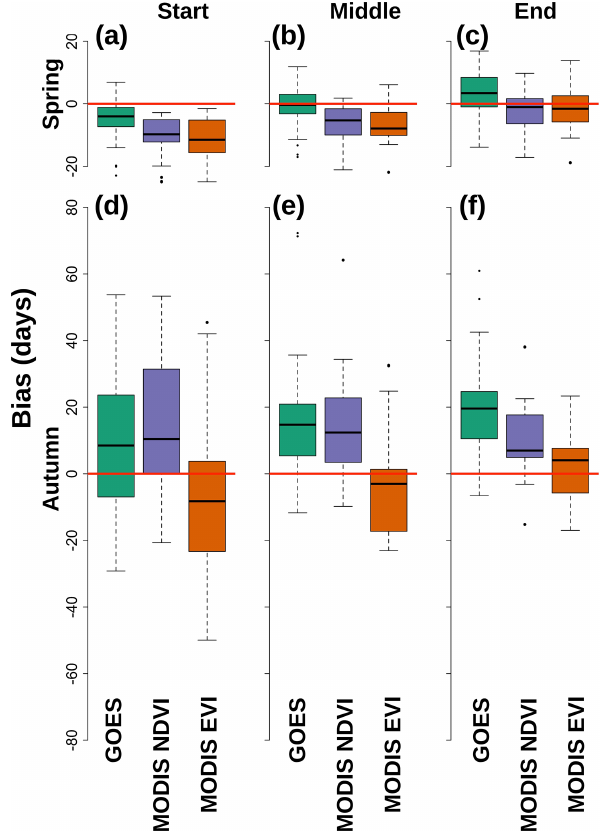
Figure 6. The different biases for the different satellite-based data sources compared to PhenoCam for their estimation of spring start (a) , middle (b) , and end (c) and autumn start (d) , middle (e) , and end (f) . A negative bias indicates the given data source was earlier than PhenoCam. The red line denotes zero bias. Boxes are color coded by the data source as indicated on the x axis. The biases are larger in the autumn than in the spring. There are some with little median